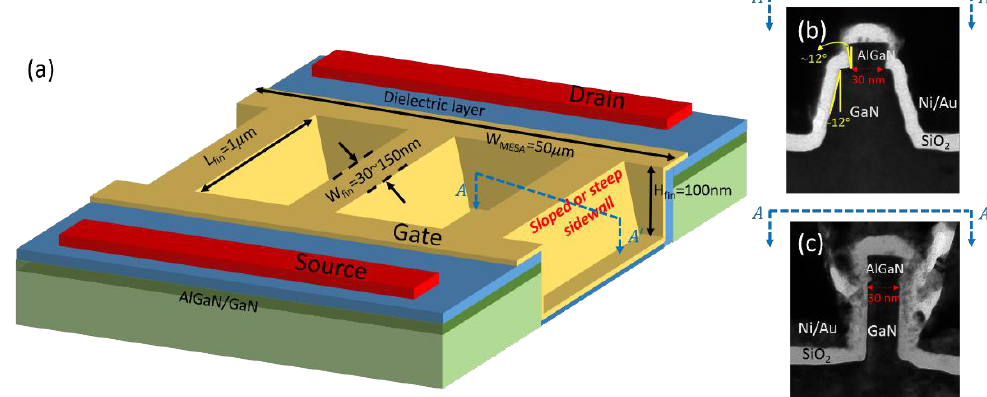
Figure 1. ( a ) Schematic image of AlGaN/GaN-based FinFET with either sloped sidewall surface or steep sidewall surface; ( b ) Cross-sectional TEM image of fin with sloped sidewall surface; ( c ) Cross-sectional TEM image of fin with steep sidewall surface.